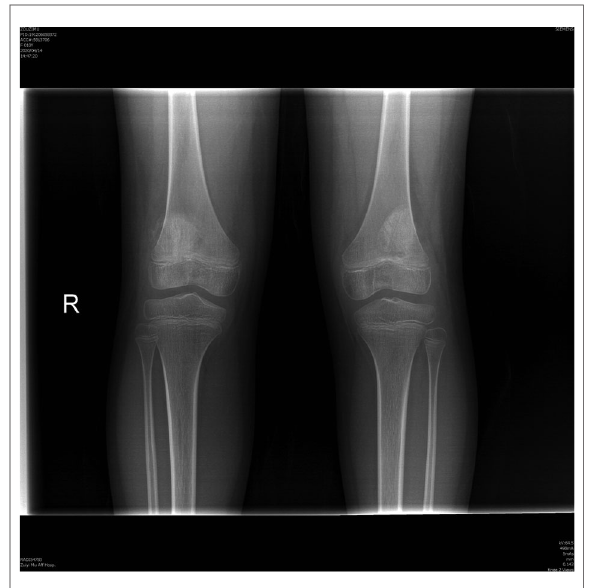
FIGURE 4 Post-operative AP radiograph of the both knees after removal of Kirschner and cerclage